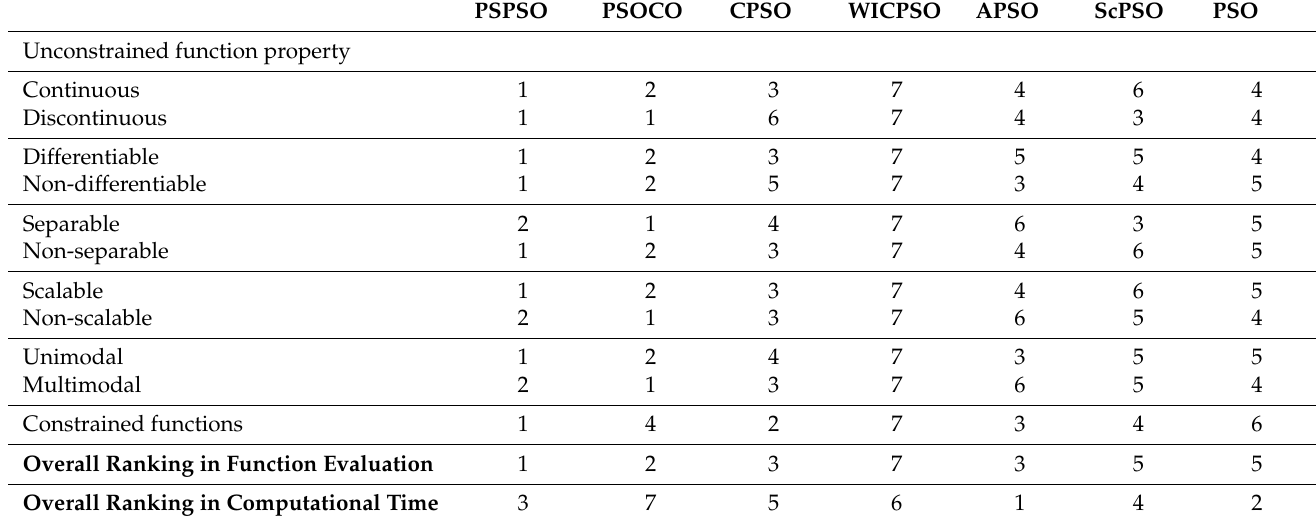
Table 10. Ranking of each PSO variant (D =